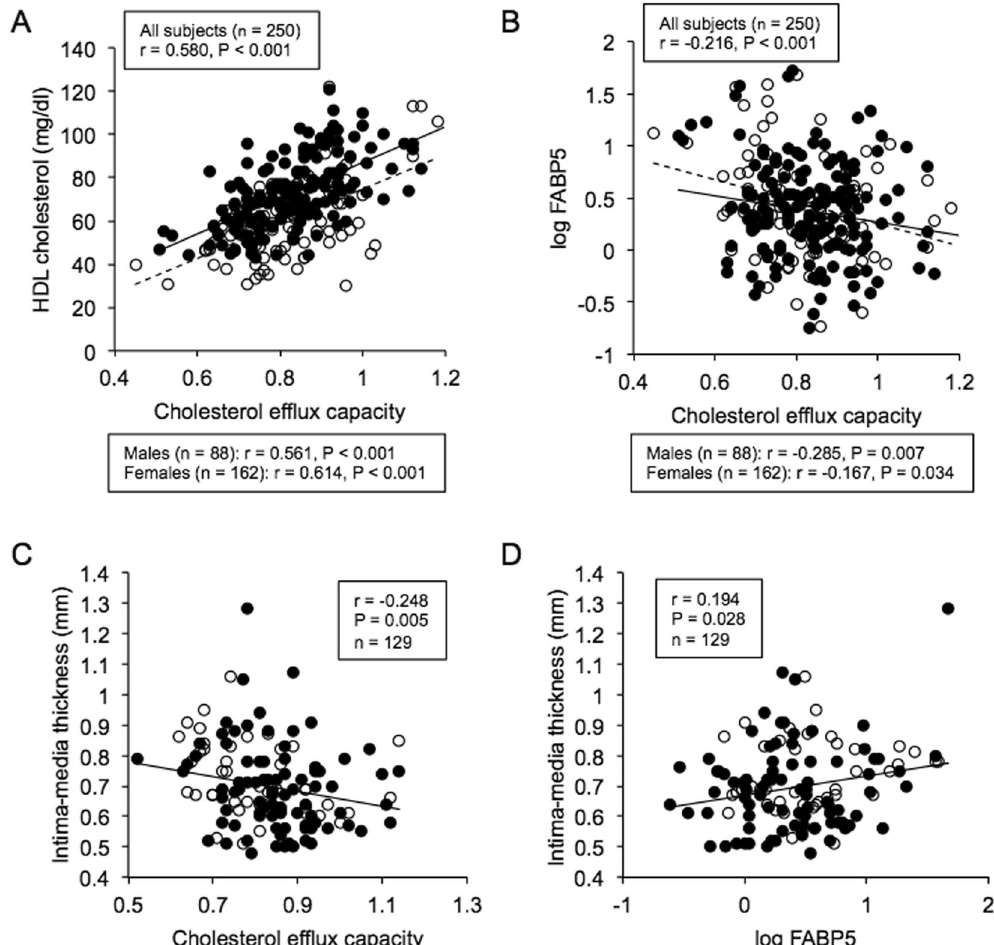
Figure 1. Correlations between cholesterol efflux capacity, levels of HDL cholesterol and FABP5 and carotid atherosclerosis. ( A , B ) HDL cholesterol level ( A ) and log FABP5 ( B ) were plotted against cholesterol efflux capacity in each subject (n = 250). Open circle and broken regression line: males (n = 88), closed circle and solid regression line: females (n = 162). ( C , D ) Mean intima-media thickness (IMT) was plotted against cholesterol efflux capacity ( C ) and log FABP5 ( D ) in each subject who underwent carotid ultrasonography (n = 129). Open circle: males (n = 44), closed circle: females (n =